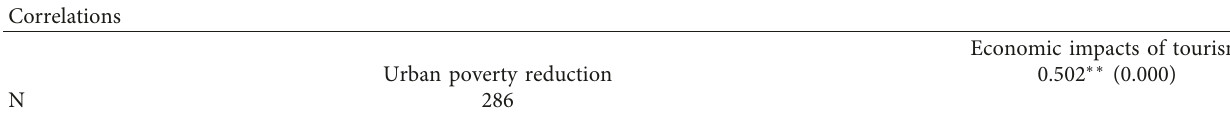
Table 4: Bivariate correlation